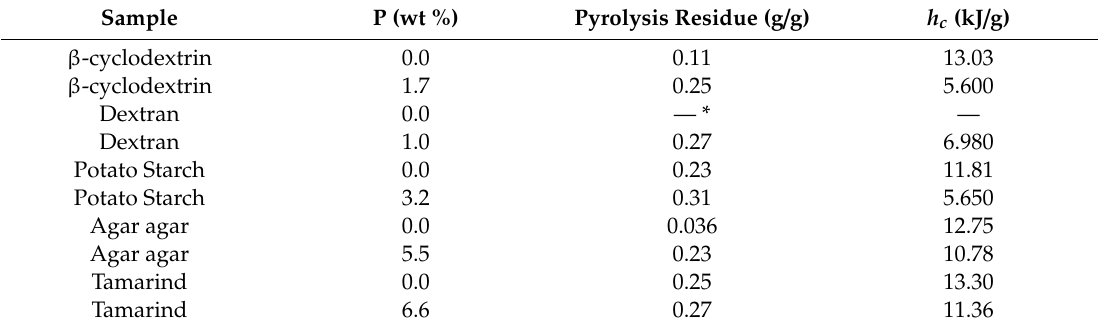
Table 4. Heats of combustion